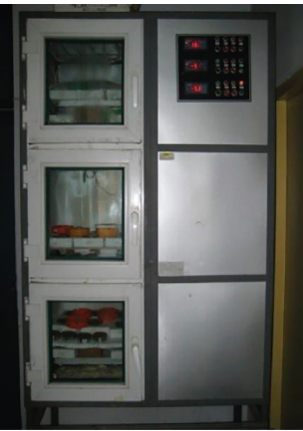
Table 3: Contents of different mineral components in the soil sample.